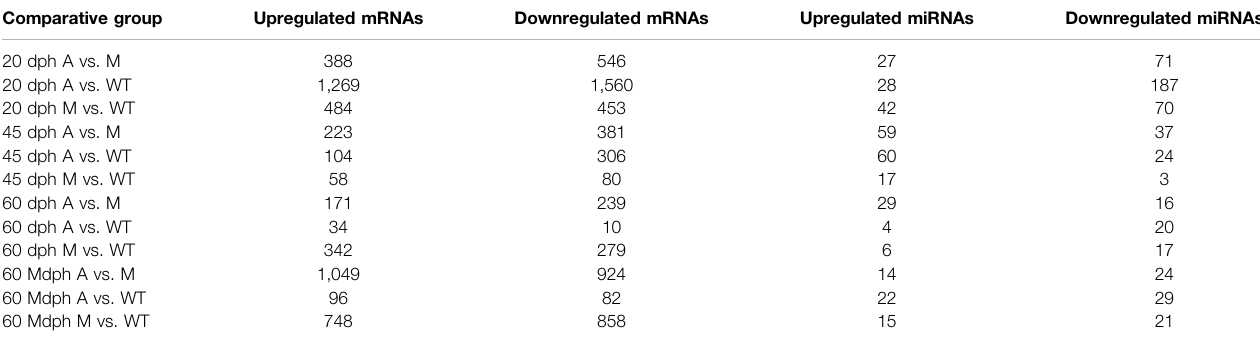
TABLE 1 | Statistics of differentially expressed mRNAs and miRNAs (A: the mutants without intermuscular bones by knocking out bmp6 on exon 1, M: the mutants with partialdeletionofintermuscularbonesbyknockingout bmp6 onexon2,WT:wild-type;thesamplesof60Mdphwerethecaudalmuscletissuescollectedfrom fi shat60 dph, the others were the musculoskeletal tissues from the caudal parts of fi sh at 20, 45, and 60 dph). Comparative group Upregulated